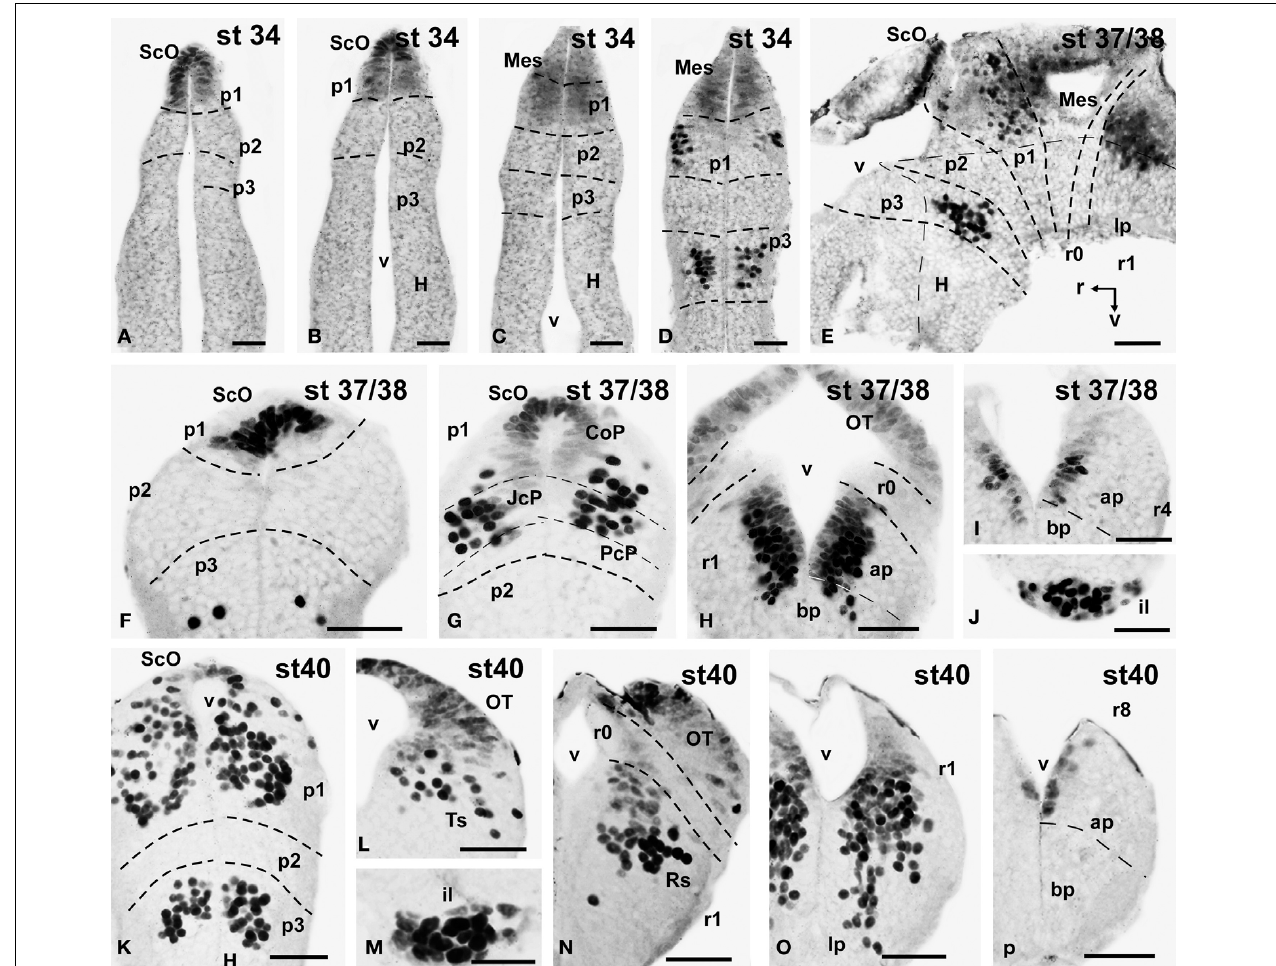
FIGURE 4 | Photomicrographs of single-stained transverse (A–D, F–P) and sagittal (E) sections through the brain of Xenopus laevis showing the localization of Pax7 cells. Different stages (indicated in the upper right corner of each photomicrograph) corresponding to early embryos are illustrated. All images are